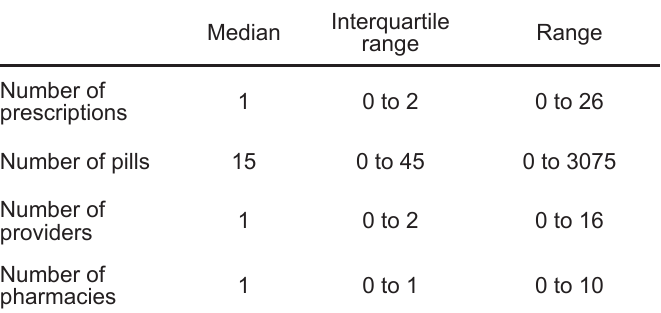
Table 1. Number of prescriptions, pills, providers writing prescriptions and pharmacies where prescriptions were filled for the prior six months in a sample of patients (n=296) who were prescribed opioids and discharged from the emergency department.